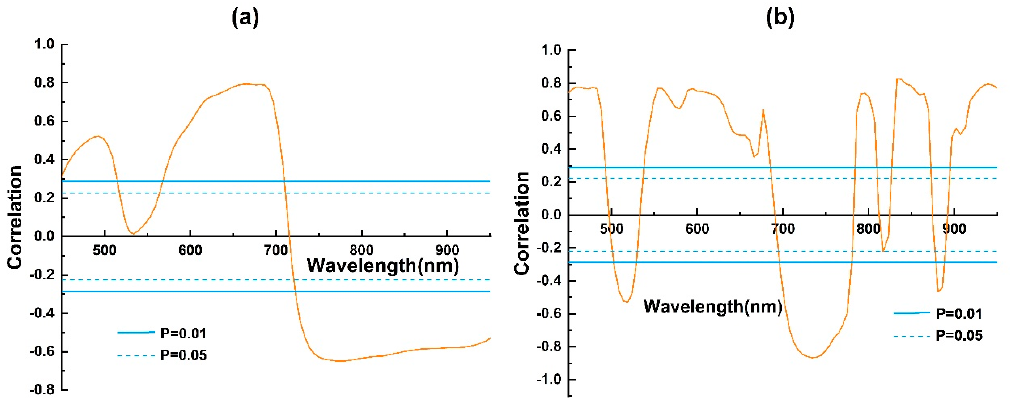
Figure 11. Correlation coefficient comparison between spectral reflectance and the first derivative of Pinus yunnanensis with different damage degrees by Tomicus (Needle) ( a ). The correlation coefficient between spectral reflectance and different damage degree of Pinus yunnanensis needles; ( b ). The correlation coefficient between the different damage degrees of Pinus yunnanensis needles and the first derivative of Pinus yunnanensis needles.